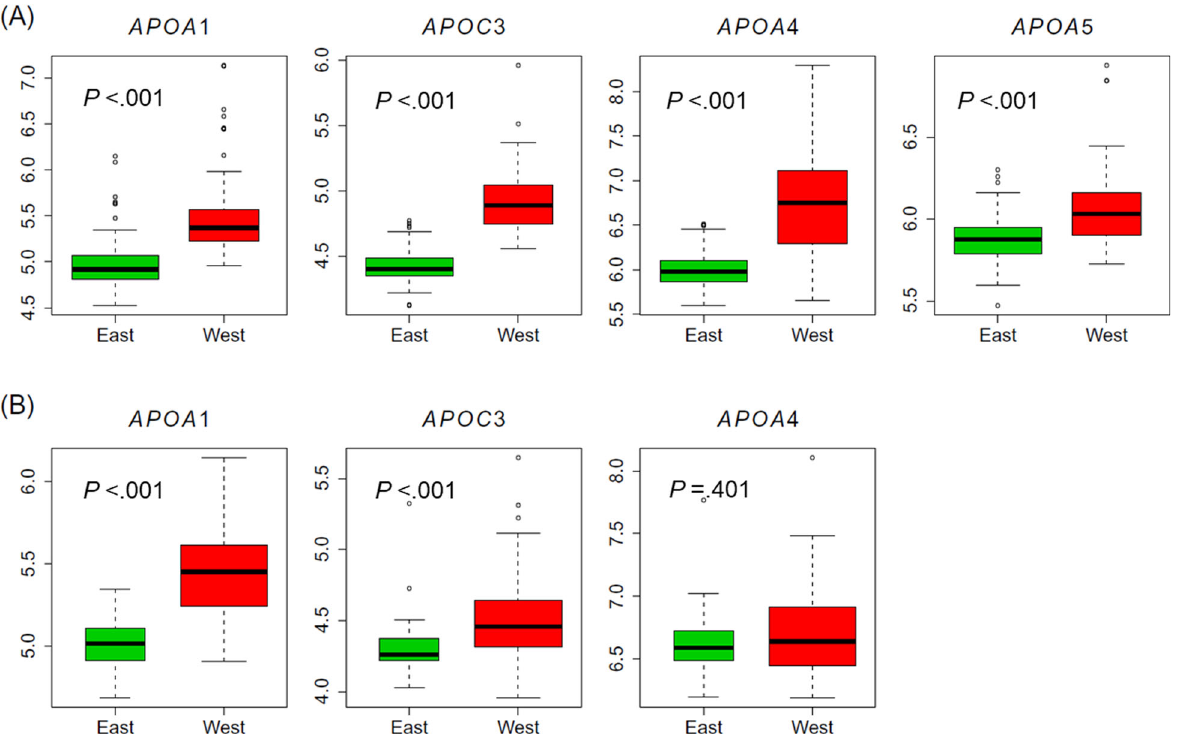
Fig. 3 GEs of APOA1 , APOC3 , APOA4 , and APOA5 . Comparisons of APOA1 , APOC3 , APOA4 , and APOA5 gene expressions the ER + /HER2- tumors between East Asian (East) and Western patients (West) aged <50 years by analyzing GSE20685, GSE21653, and GSE23720 datasets ( A ), and by GSE2019 and GSE45255 datasets ( B ). Table 4. Associations of expressions of APOA1, APOC3, APOA4 , and APOA5 with ESTIMATE immune score in breast tumors of East Asian and Western